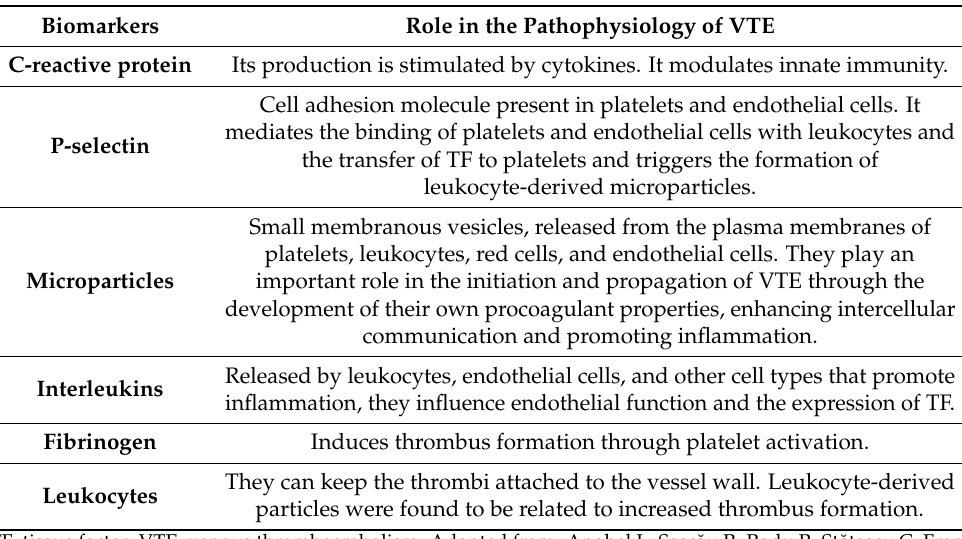
Table 1. The role of different inflammatory biomarkers in the pathophysiology of venous throm- boembolism